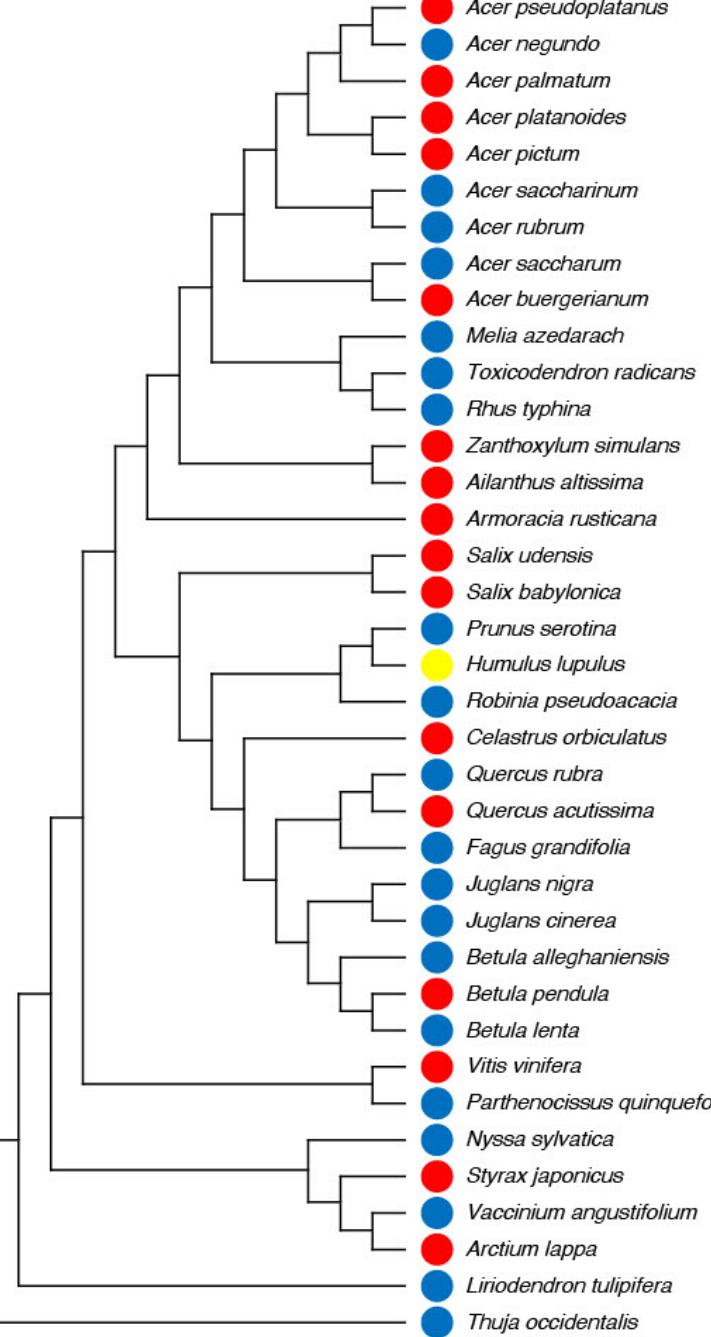
Figure 4. Phylogenetic relationships constructed based on sequence data for the rbc L gene (ribulose- 1,5-biphosphate carboxylase-oxygenase) for native (blue circles) and introduced (red circles) host plants of Lycorma delicatula . The status for Humulus lupulus (yellow circle) was determined as “both” according to the USDA Plant Database. Sequences were retrieved from the NCBI GenBank Database. Maximum likelihood tree with bootstrap replicates of 150 was generated using Molecular Evolutionary Genetics Analysis (MEGA) software (v. 10.0.5).